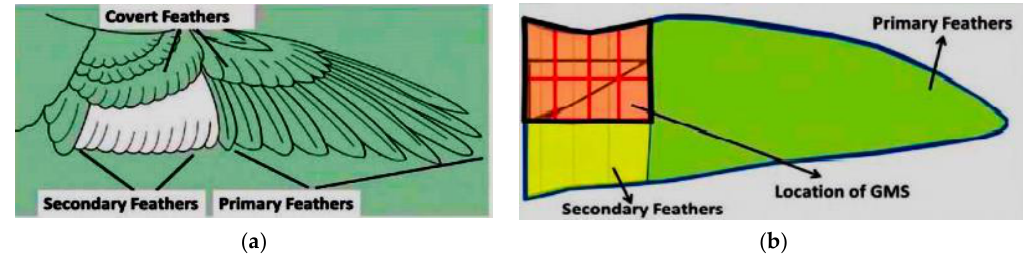
Figure 21. Mechanisms to offset turbulent gusts of wind ( a ) covert feathers in birds ( b ) positioning of a GMS unit [74].